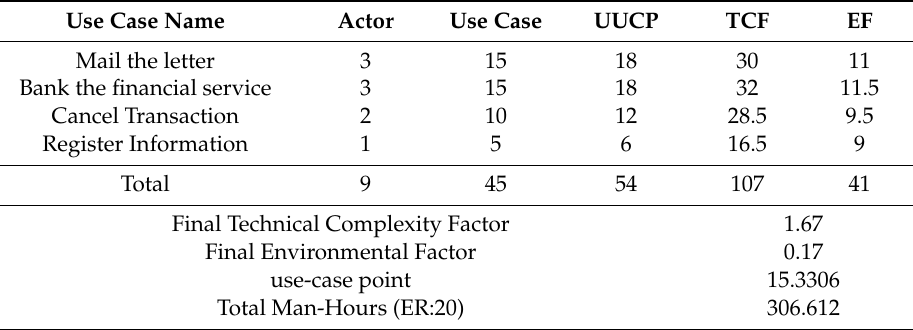
Table 5. Mapping parts of speech to object model components